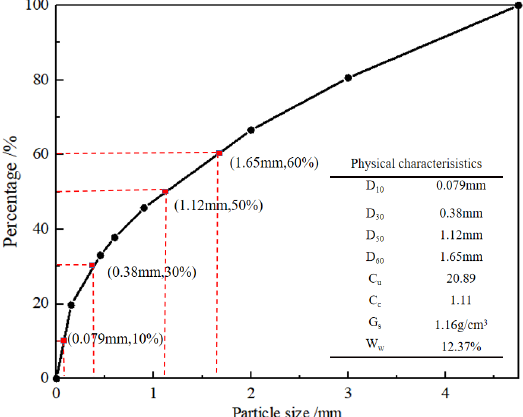
Figure 1. The size distribution of weathered rare earth ores, including its key physical characteristics.